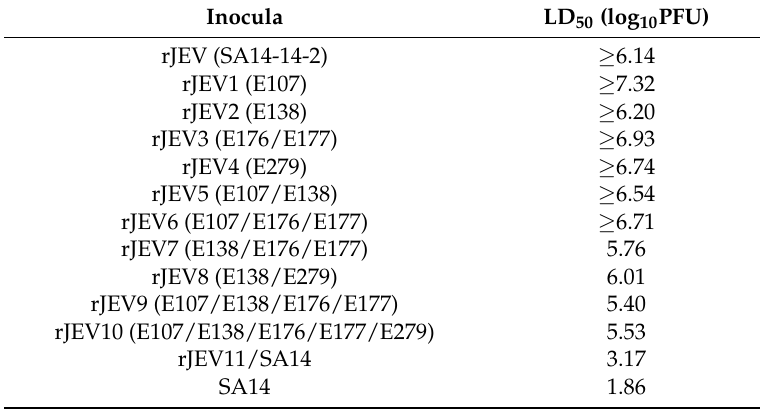
Table 4. Neuroinvasiveness of the revertant viruses in 3-week-old mice inoculated by the s.c.